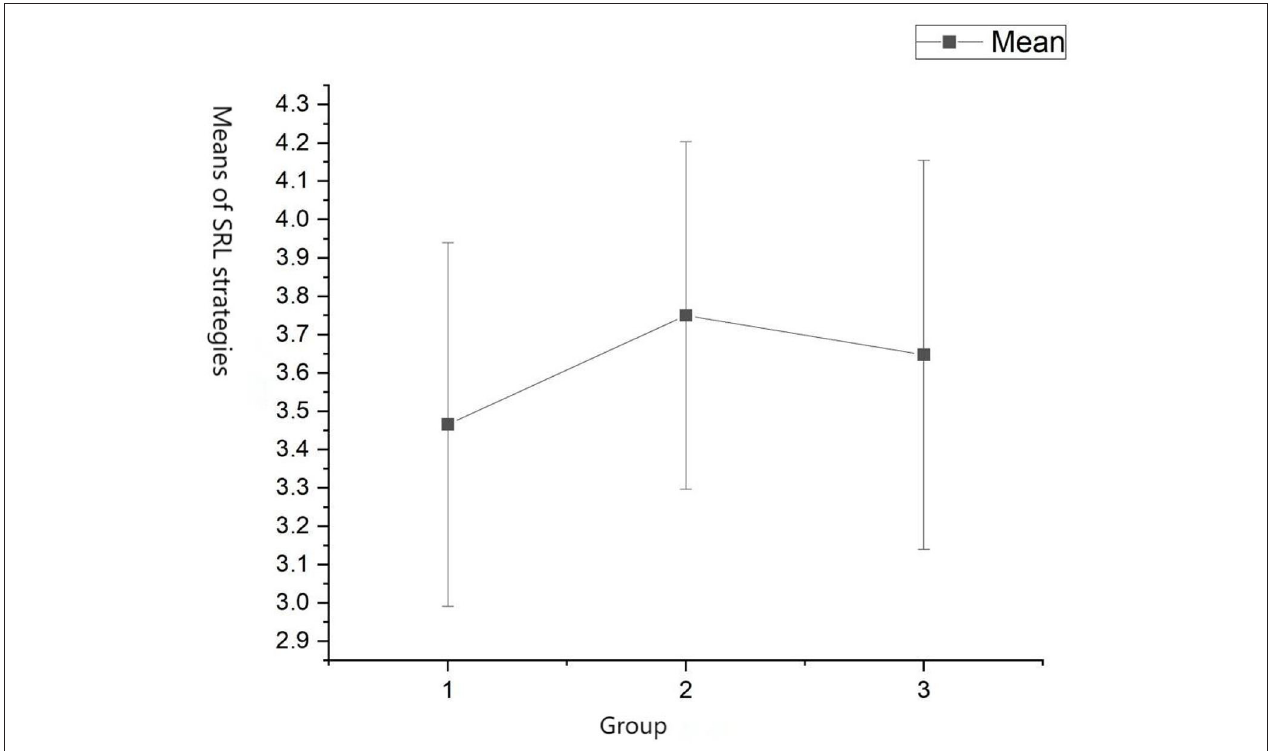
FIGURE 8 | Means plot of SRL strategies.